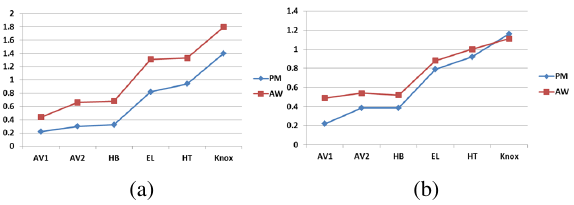
Figure 13: RMSE comparison of (a): building detection; (b): roof plane extraction. PM: proposed method and AW: Awrangjeb’s